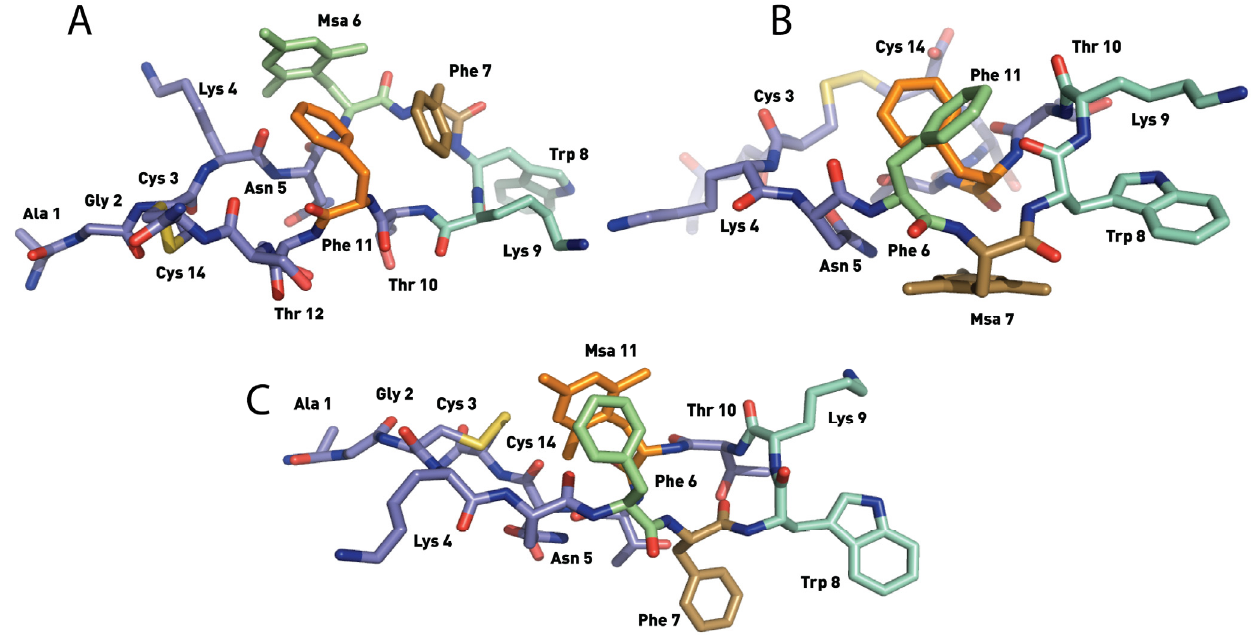
Figure 4. Structures of the lowest energy conformers of [L-Msa6]-SRIF ( 1 ) ( A ), [L-Msa7]-SRIF ( 2 ) ( B ) and [L-Msa11]-SRIF ( 3 ) ( C ). Hydrogen atoms have been omitted for